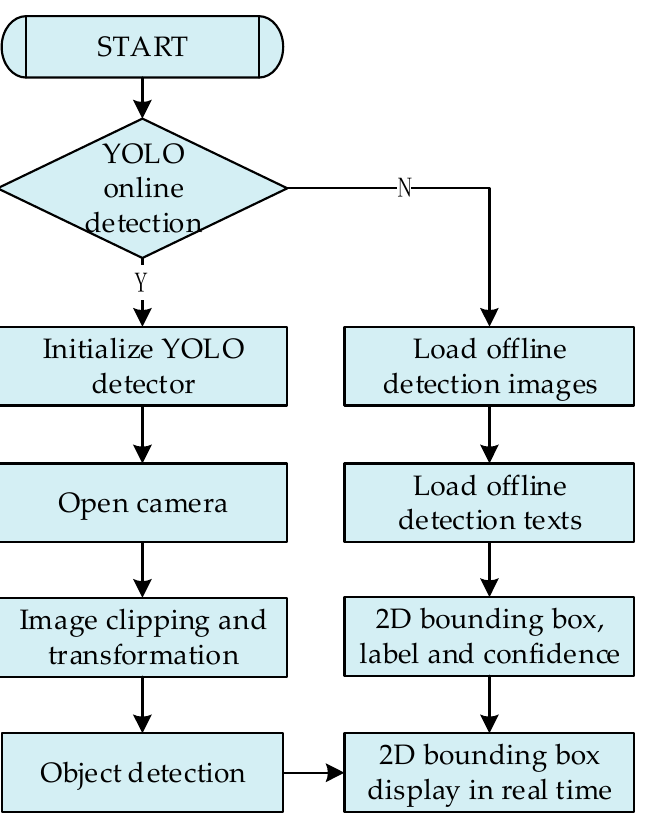
Figure 11. The flow chart of the object detection module.